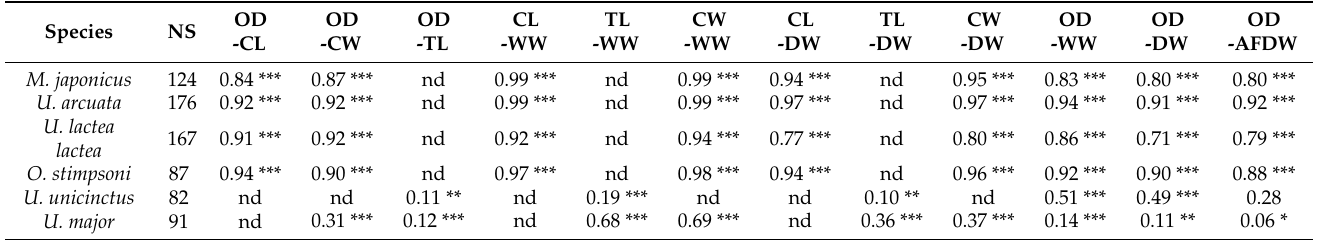
Table 3. Comparison of regression coefficients (R 2 ) between opening diameter, body size, and biomass of each species (* p < 0.05, ** p < 0.01, *** p <